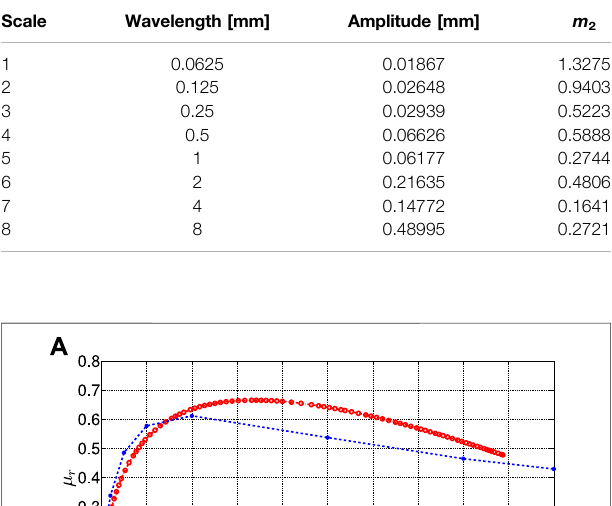
TABLE 2 | Surface approximation for the asphalt specimen using 8 sine waves.